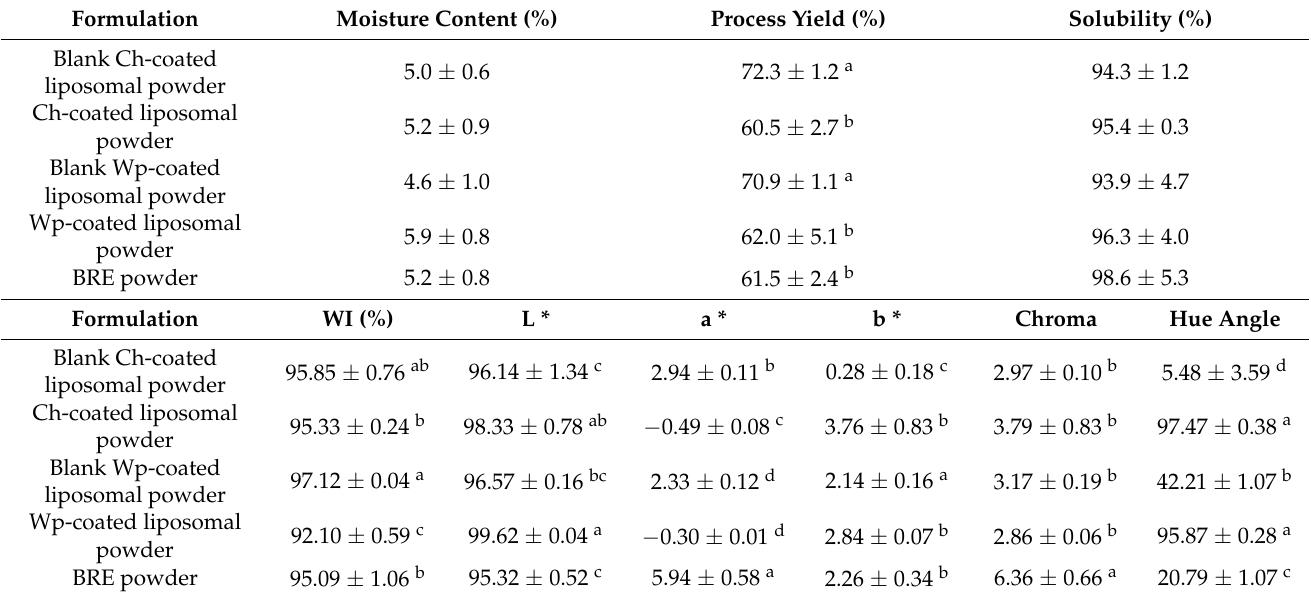
Table 7. Characterization of spray-dried black rosehip extract (BRE) and BRE-loaded liposomal